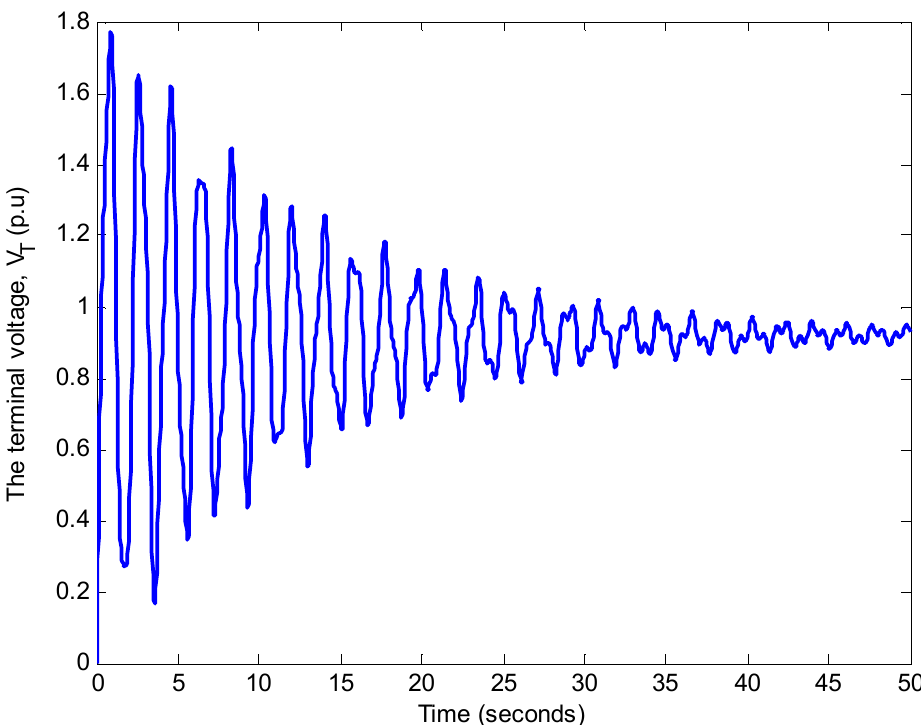
Figure 19. The terminal voltage with a 0.3744 s time delay.